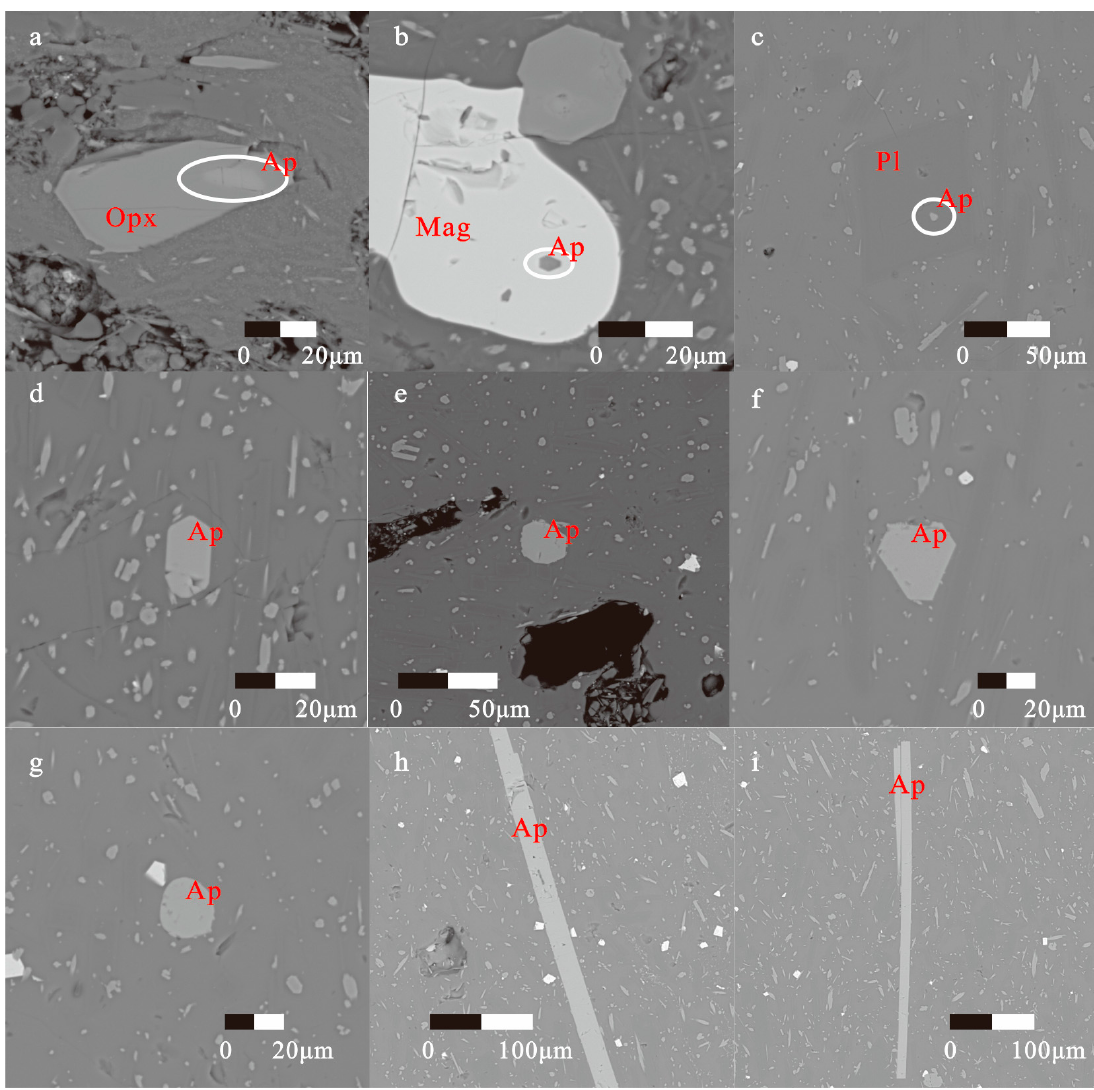
Figure 3. Back-scattering images of apatites in dacite from the Eastern Manus Basin. ( a ) Ap- atite in orthopyroxene; ( b ) Apatite in magnetite; ( c ) Apatite in plagioclase; ( d – g ) Apatite